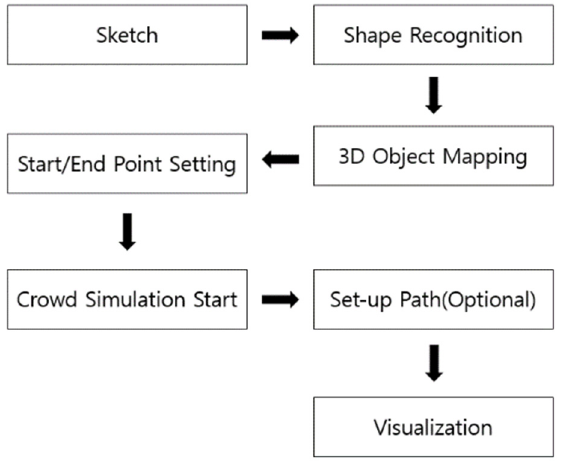
Figure 3. Overview of the CoR-SketchAR system.